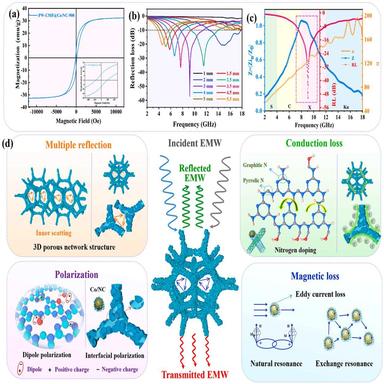
(a) Magnetic hysteresis loops of PW-CMF@Co/NC-900 composite PCMs; (b) RL curves of PW-CMF@Co/NC-900 composite PCMs; (c) Frequency-dependent α, RL, and |Zin/Z0| values of PW-CMF@Co/NC-900 composite PCMs; (d) Schematic illustration of the microwave absorption mechanism of PW-CMF@Co/NC-900 composite PCMs.